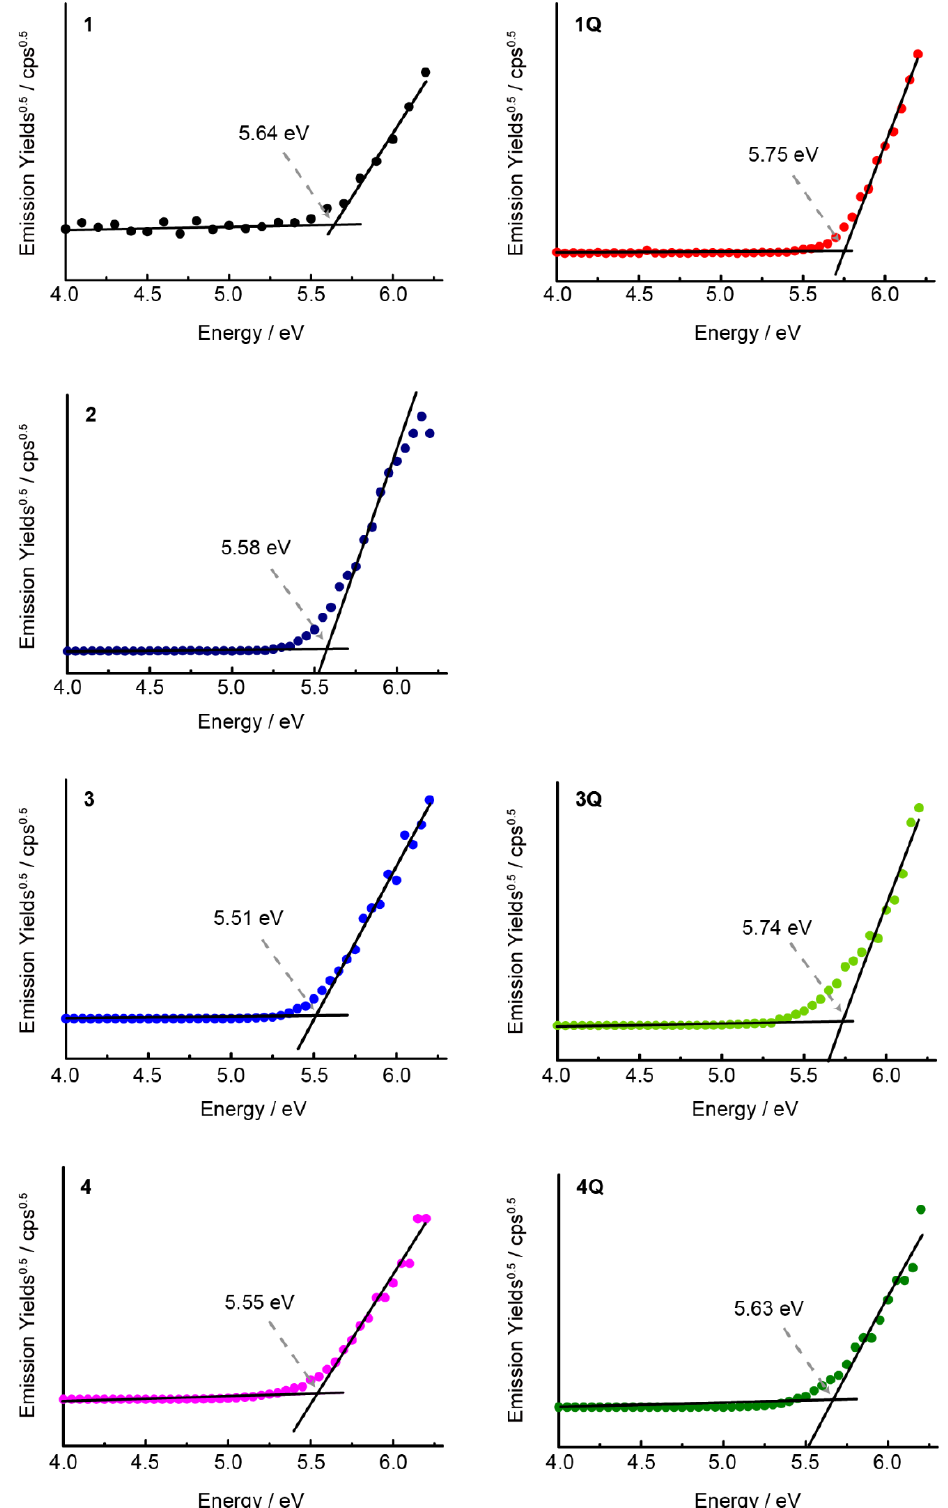
Figure 6. Photoelectron spectra of spin-coated thin films of SubPcs on an ITO glass substrate.